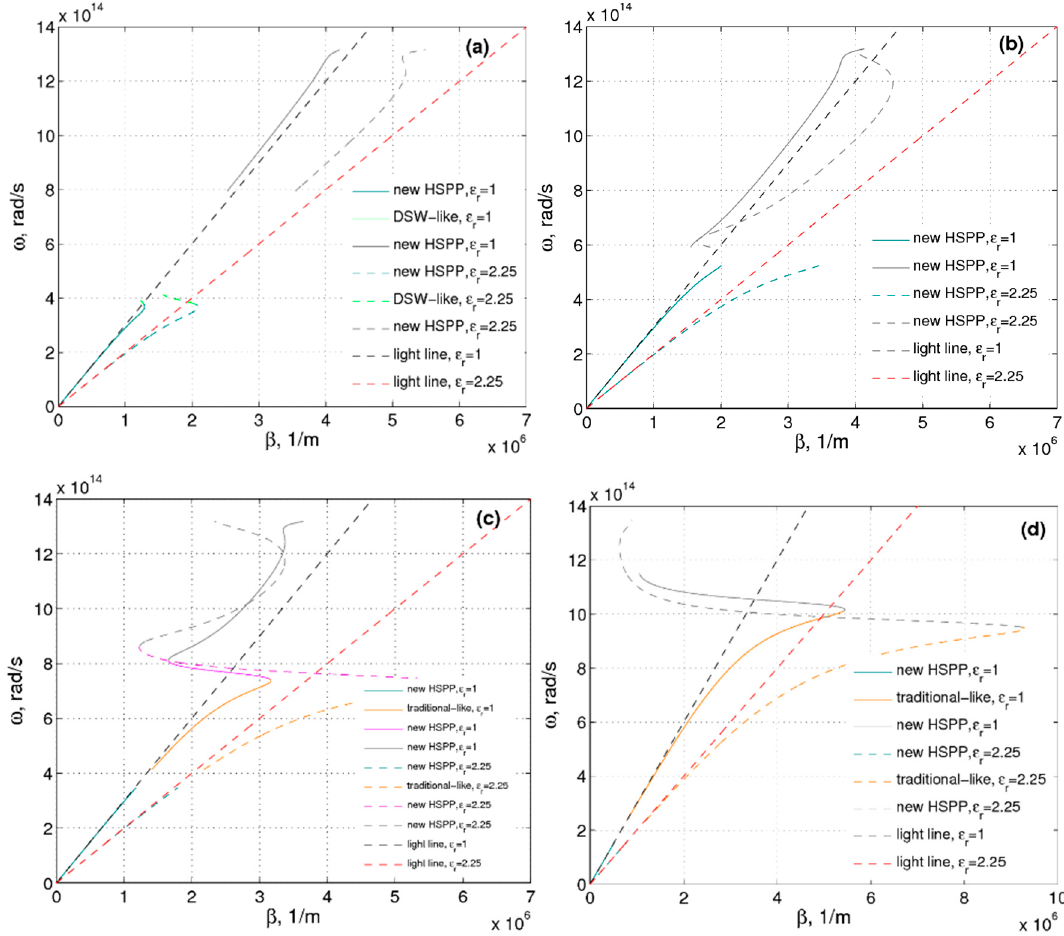
Figure 12. SPP dispersion for different TCO filling factors, i.e., f TCO = 0.3 in ( a ), f TCO = 0.5 in ( b ), f TCO = 0.7 in ( c ), and f TCO = 0.9 in ( d ), matching the MM/dielectric